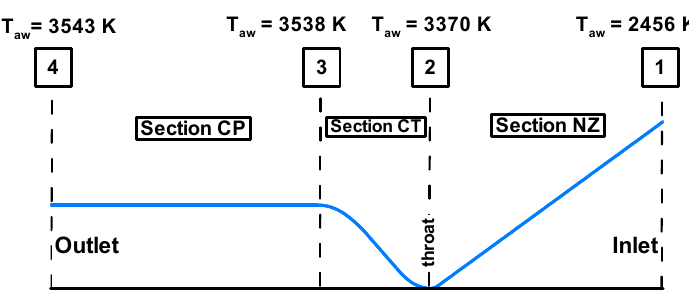
Figure 9. Sketch reporting the hot gas average temperature (K) values along the engine for the cylindrical part, convergent, throat and nozzle sections, evaluated through RPA code.